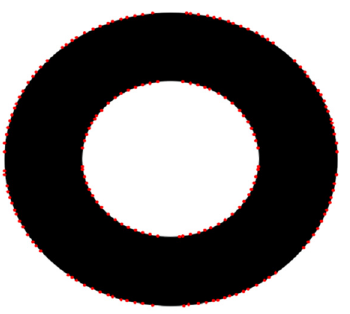
Figure 5. Results of sub-pixel algorithm detection.